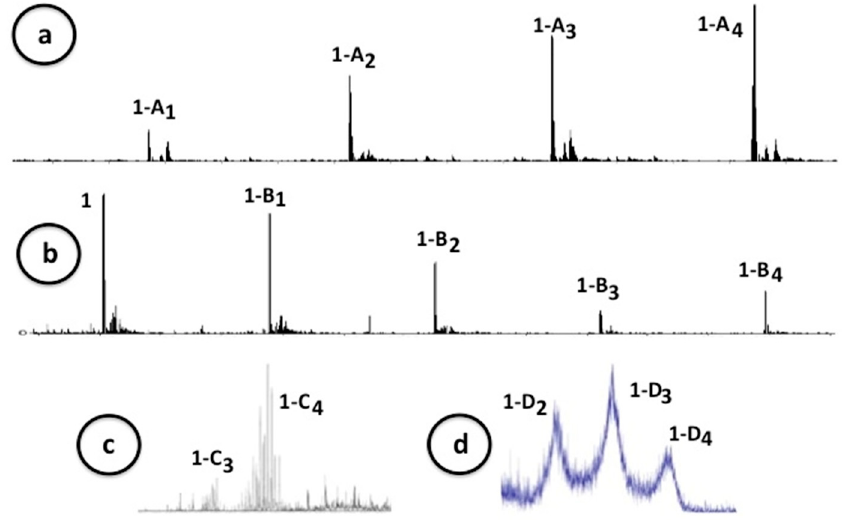
Figure 3. Conjugates 1 with A ( a ); B ( b ); C ( c ) and D ( d ). Traces ( a , b ) are taken upon the addition of thiol by ESI-TOF MS. Mass scales for these traces are m / z 2900-4400 ( a ) and m / z 2600-5200 ( b ); Traces ( c , d ) are taken of the purified product mixture. Mass scales for these traces are m / z 4500–7800 ( c ) and m / z 5000–13000 ( d ). Trace ( d ) was obtained by MALDI-TOF-MS.